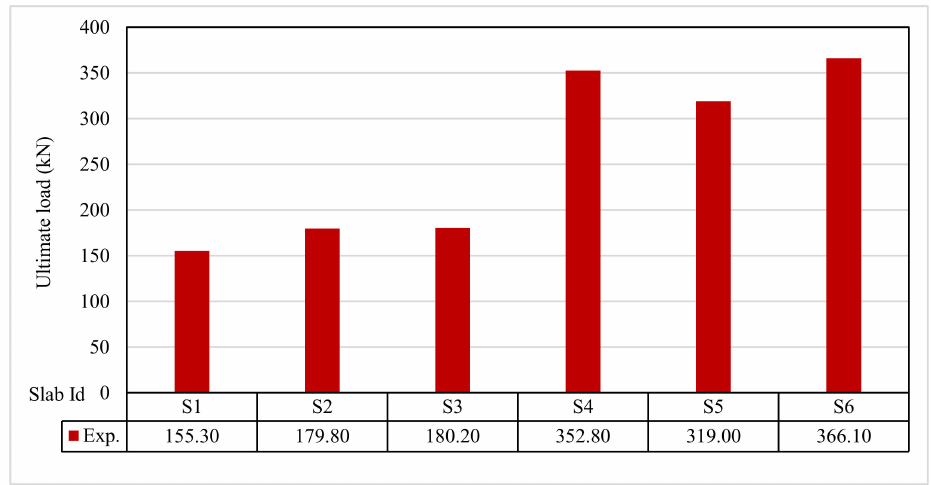
Figure 13. Ultimate load for tested slabs.